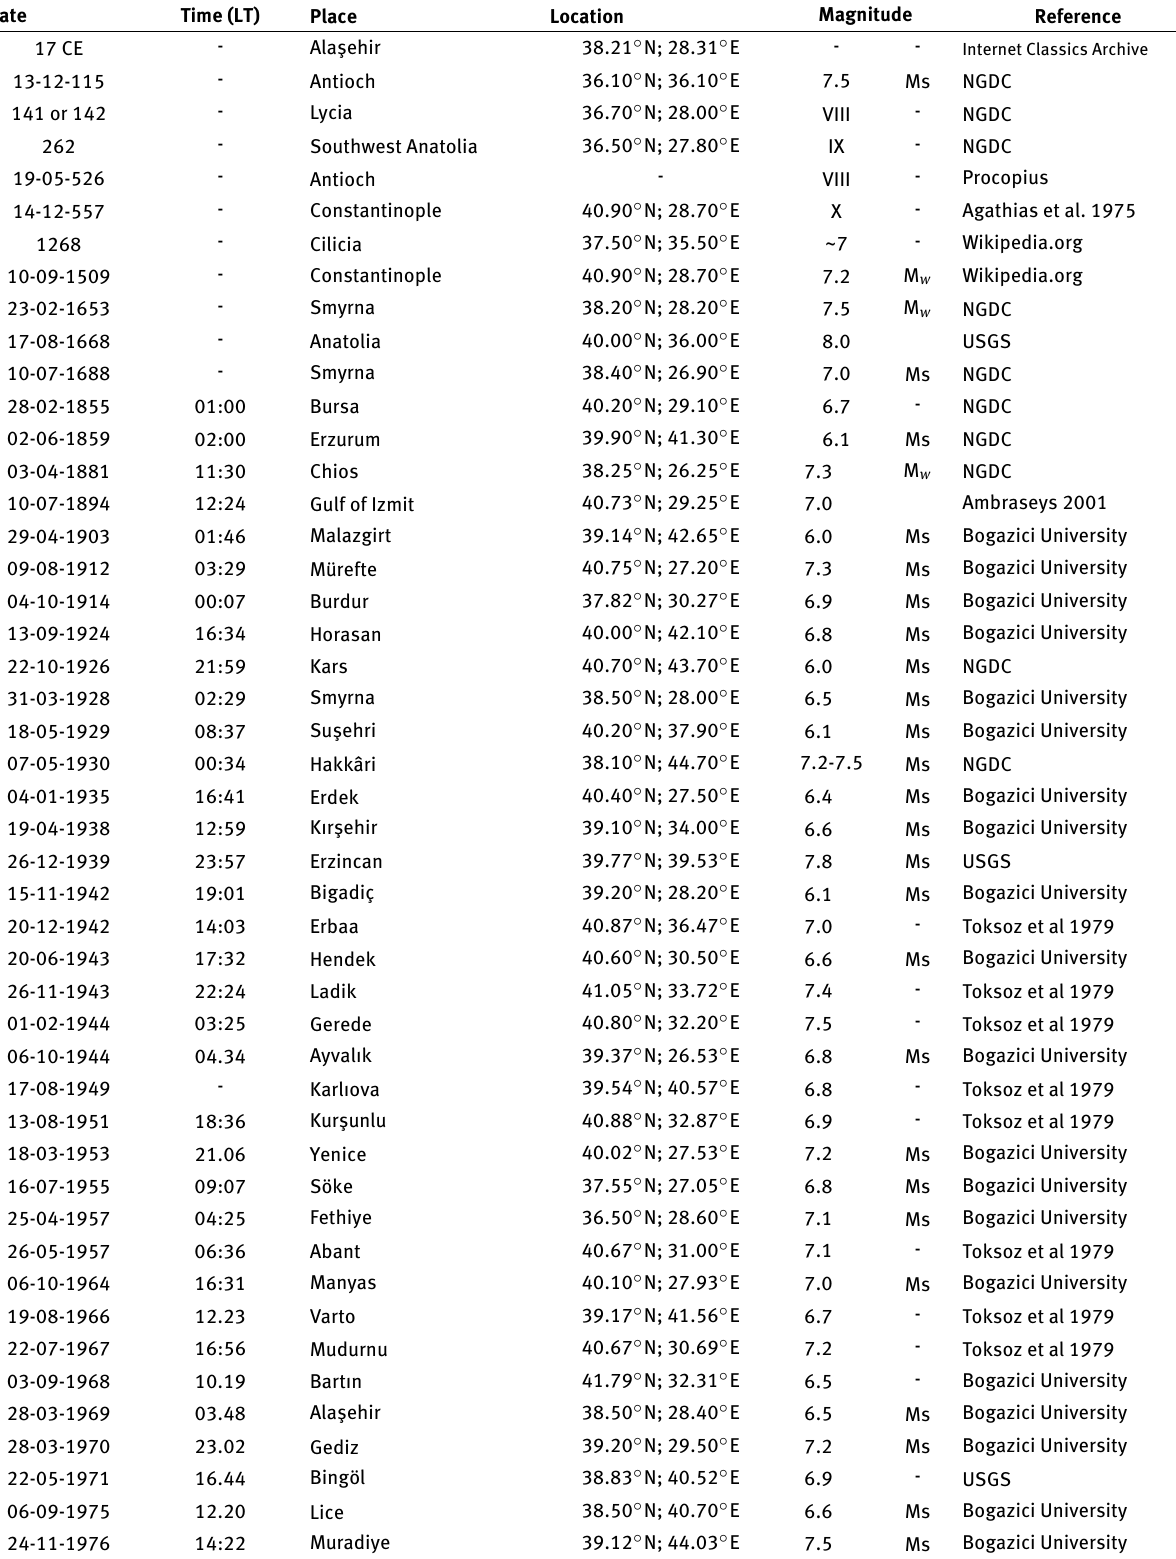
Table 1: The list of historical earthquakes of Turkey available in literature according to my search till